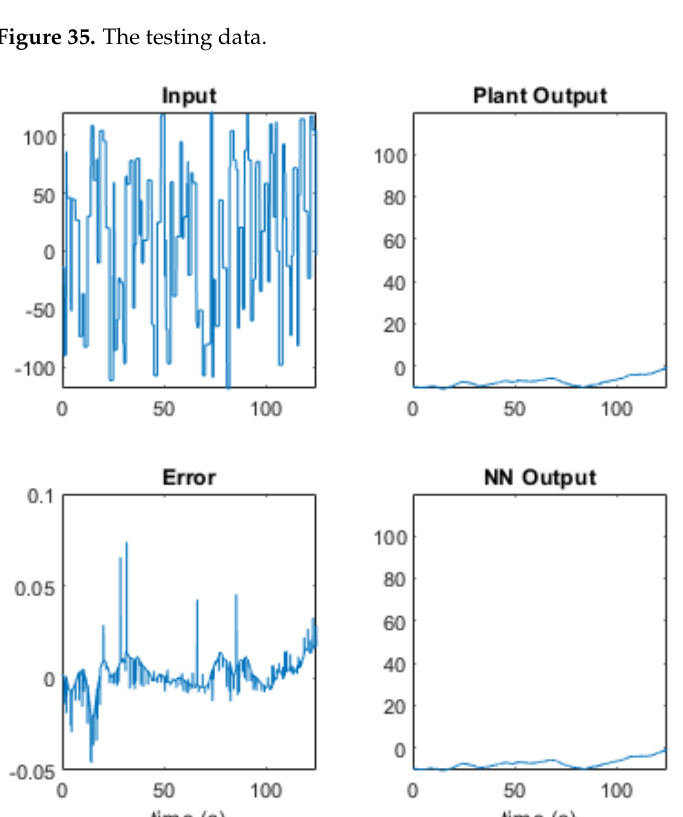
Figure 35. The testing data.